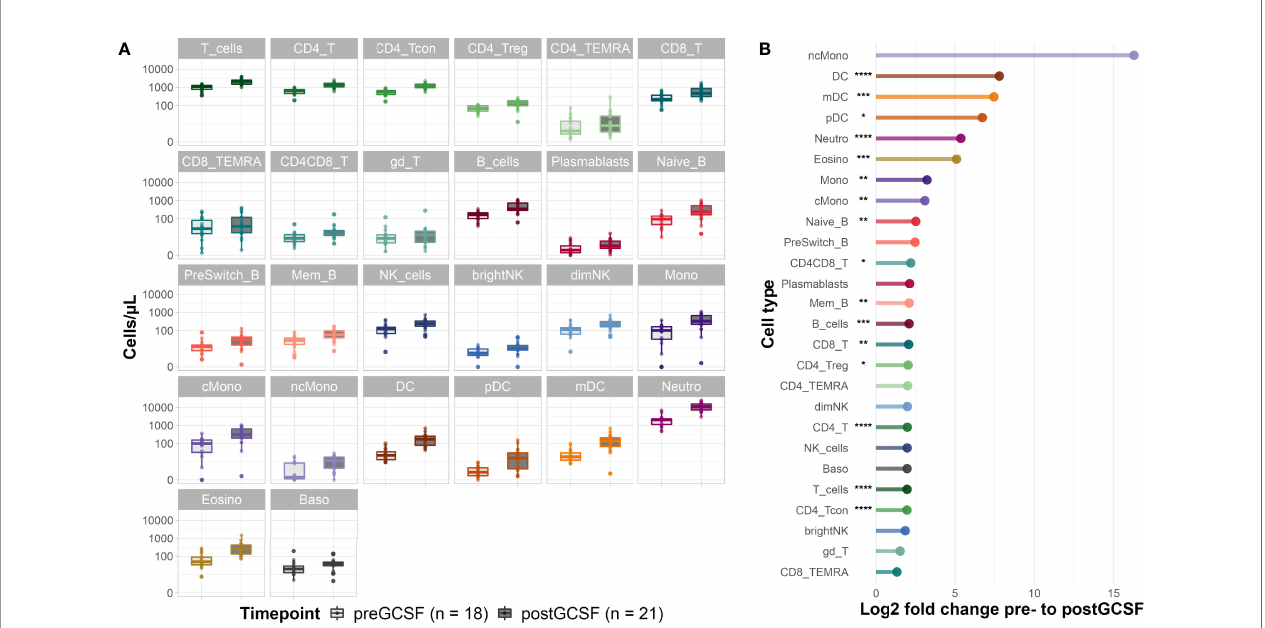
FIGURE 2 | Donor cell counts before and after G-CSF mobilization. (A) Median cell counts per µl whole blood with 25th and 75th percentiles before and after G-CSF treatment. (B) Log2 fold changes of the median cell counts before and after G-CSF stimulation. Signi fi cance levels were calculated with the Wilcoxon signed rank test with *p < 0.05 **p < 0.01 ***p < 0.001 ****p < 0.0001; T_cells, T cells; CD8_T, CD8 T cytotoxic cells; CD8_TEMRA, CD8 terminally differentiated memory T cells; CD4_T, CD4 T helper cells; CD4_Treg, Regulatory CD4 T cells; CD4_Tcon, Conventional CD4 T cells; CD4_TEMRA, CD4 terminally differentiated memory T cells; CD4CD8_T, CD4CD8 double positive T cells; gd_T, gamma-delta T cells; B_cells, B cells; Naive_B, Naive B cells; NonSwitch_B, Non-switched memory B cells; Mem_B, Memory B cells; Plasmablasts, Plasmablasts; NK_cells, NK cells; brightNK, CD56 bright NK cells; dimNK, CD56 dim NK cells; Mono, Monocytes; cMono, Classical monocytes; ncMono, Non-classical monocytes; DC, Dendritic cells; pDC, Plasmacytoid dendritic cells; mDC, Myeloid dendritic cells; Neutro, Neutrophils; Eosino, Eosinophils; Baso,